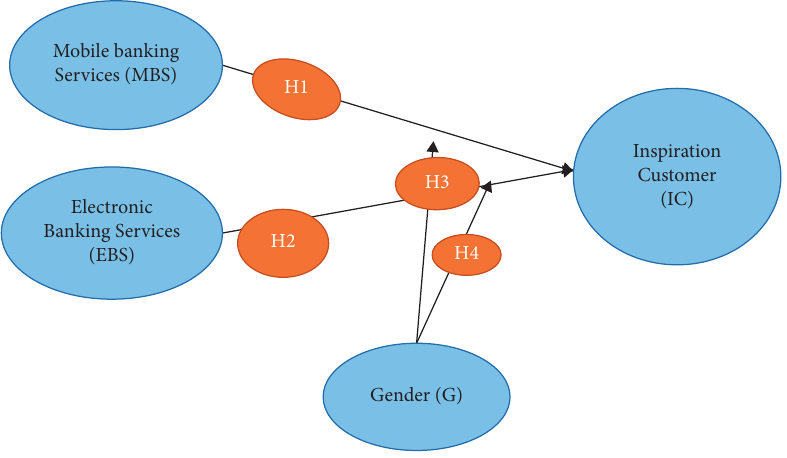
Figure 1: Research model. Table 3: Measurement model analysis.